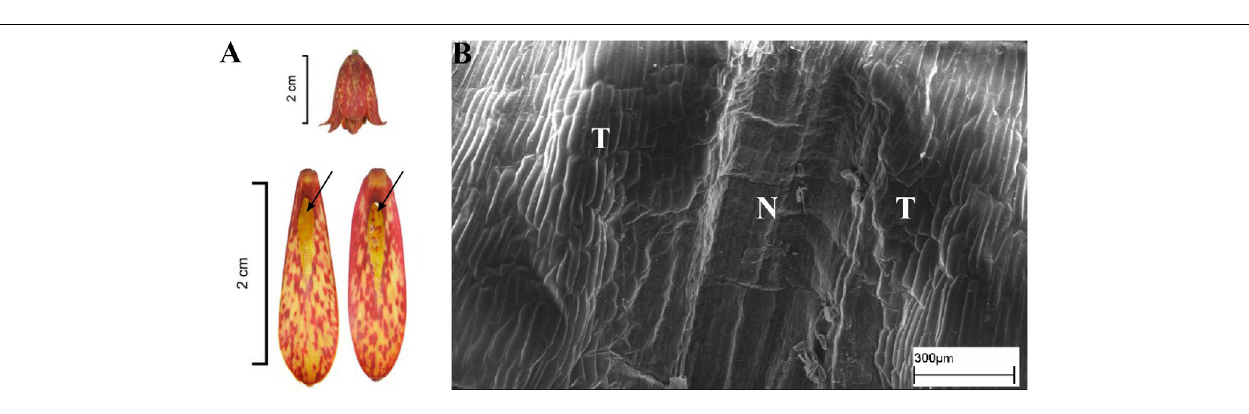
FIGURE 9 | Flowers and nectaries of F. gentneri . Macro and SEM images. (A) Flowers and tepals, nectaries marked with arrows. (B) Part of outer tepal showing deeply depressed nectary